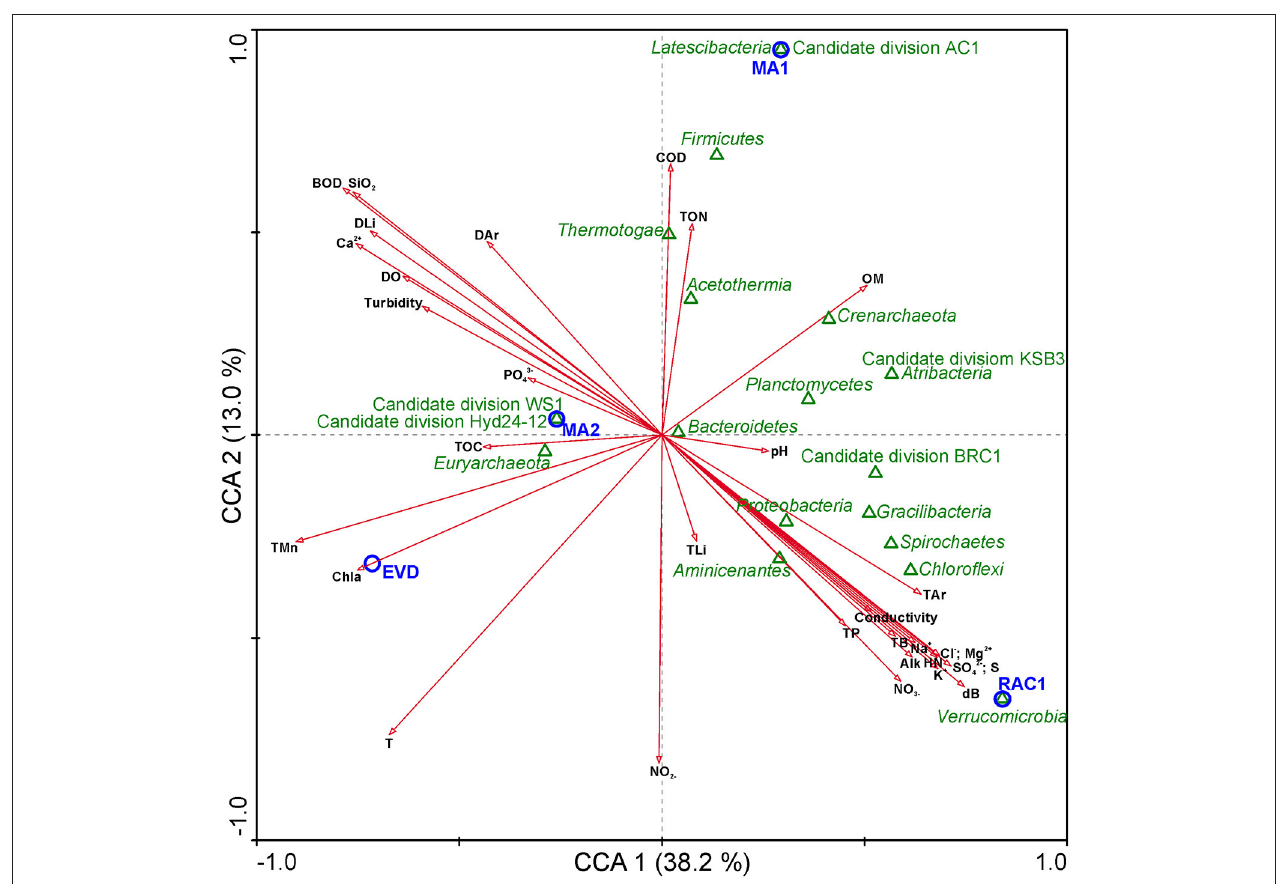
FIGURE 5 | Canonical correspondence analysis (CCA) of microbial community, samples, and environmental parameters. Arrows indicate the direction and magnitude of environmental parameters associated with phyla (open green triangles) and samples studied (open blue circles). BOD, Biochemical oxygen demand; COD, Chemical oxygen demand; Chl a , Chlorophyll a; HN, Hardness; Alk, Total alkalinity; T, Temperature; OM, Organic matter; TOC, Total organic Carbon; DO, Dissolved oxygen; NO − 3 , Nitrate; NO − 2 , Nitrite; TON, Total organic nitrogen; TP, Total phosphorus; OP, Orthophosphate; SO 2 − 4 , Sulfate; S, Sulfur; S 2 − , Total sulfide; Na + , Sodium; Cl − , Chloride; K + , Potassium; Mg 2 + , Magnesium; Ca 2 + , Calcium; DB, Dissolved boron; TB, Total boron; DLi, Dissolved lithium; TLi, Total lithium; SiO 2 , Silica; Dar, Dissolved Arsenic; Tar, Total